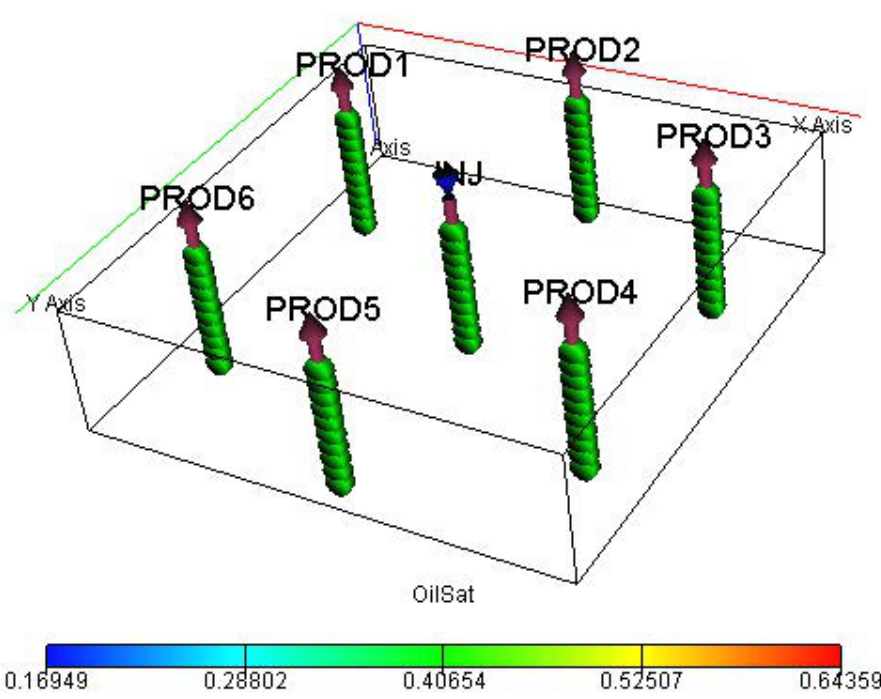
Figure 1. Shape of the reservoir.